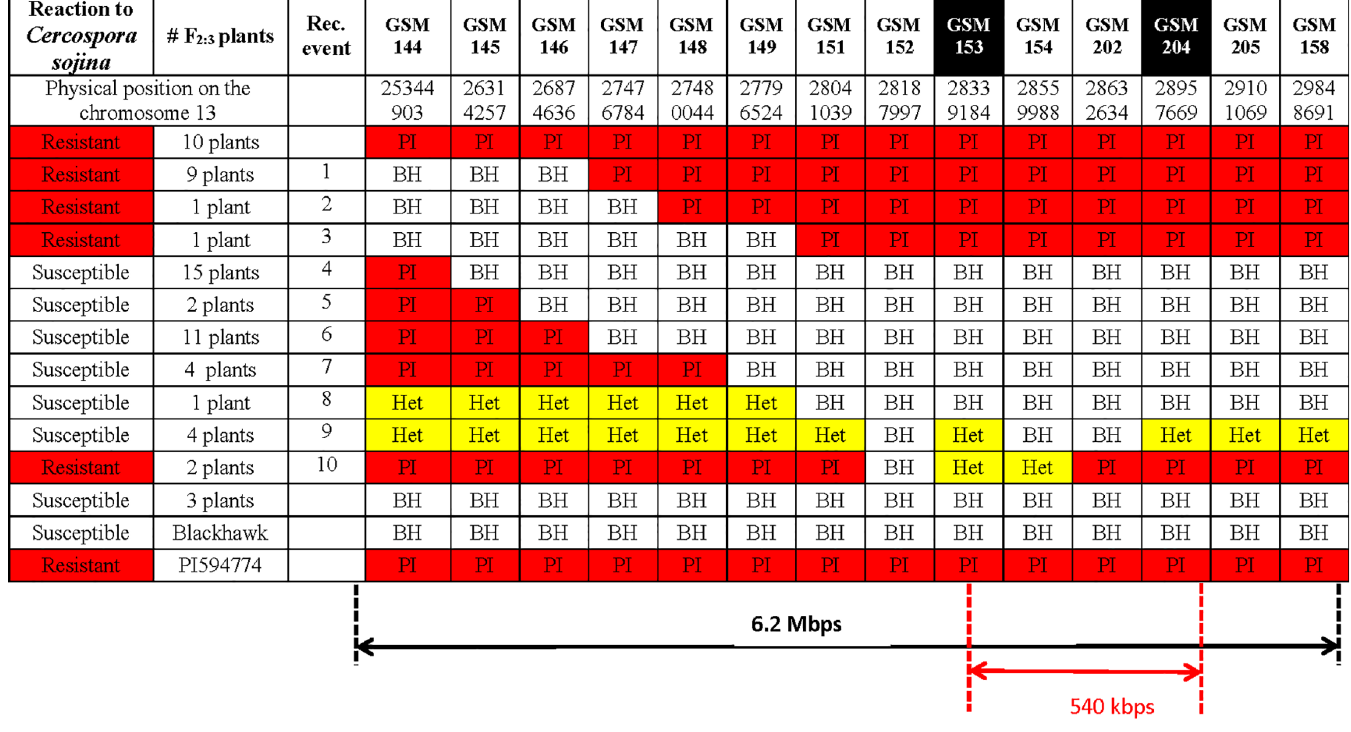
Fig 2. SNP genotypes at the 14 SNP marker loci and the reaction of F 2:3 plants with recombination events to Cercospora sojina (race 8) in a population from Blackhawk x PI 594774. (BH = Blackhawk allele; PI = PI 594774 allele; Het = heterozygous alleles).